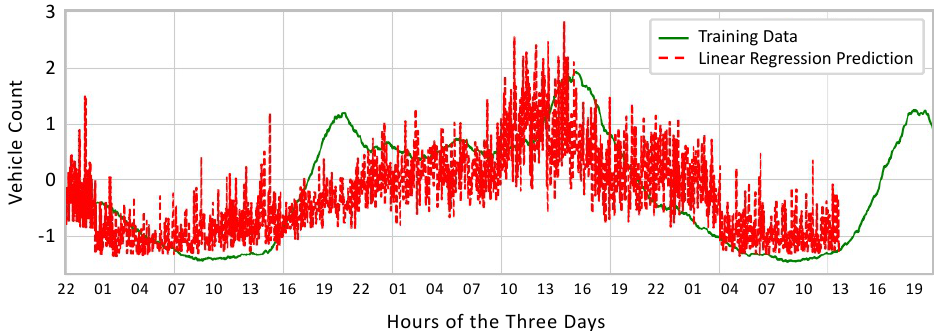
Figure 16. Linear regression prediction of vehicle